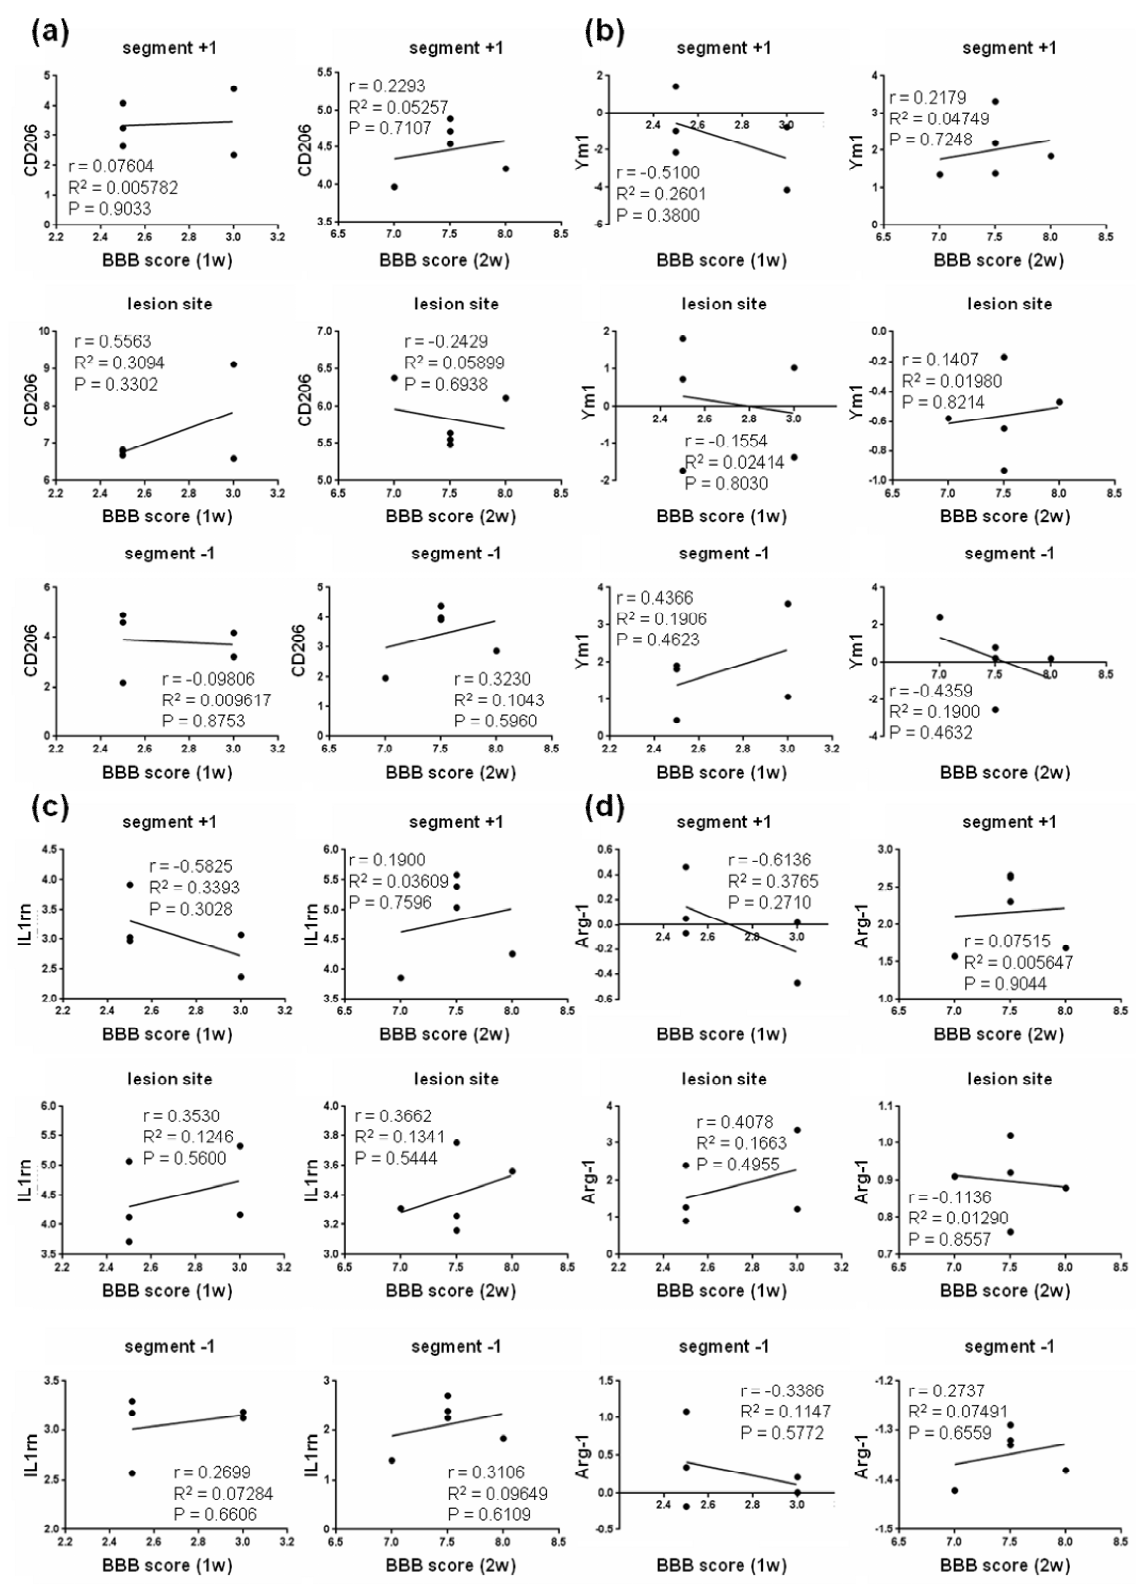
Figure 10. Linear regression analysis of correlation between BBB score and relative gene expression of markers characteristic for protective microglial M2a phenotypes—CD206 ( a ), Ym1 ( b ), IL1rn ( c ) and Arg-1 ( d ) at injury site and in adjacent cranial and/or caudal segments one and two weeks post-SCI. Scatterplots of individual values ( n = 5) with regression line correlation coefficient (r), coefficients of determination (r2) calculated using regression analysis and p -value. CD206—mannose receptor and C-type lectin; Ym1—chitinase-like protein-1; IL1rn—interleukin 1 receptor antagonist; Arg-1—arginase-1.